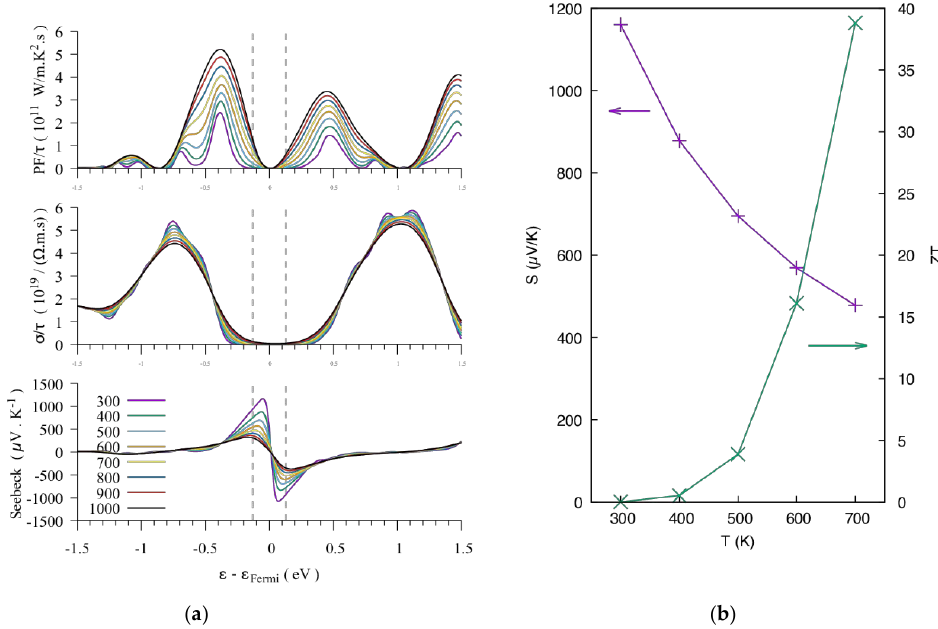
Figure 9. Thermoelectric properties of BaRh 2 Ge 4 S 4 Te 2 . ( a ) Properties plotted w.r.t. Fermi level for temperatures ranging from 300 to 1000 K. Bottom: Seebeck coefficient; middle: electrical conductivity; top: power factor. ( b ) Seebeck coefficient and ZT plotted w.r.t. temperature.